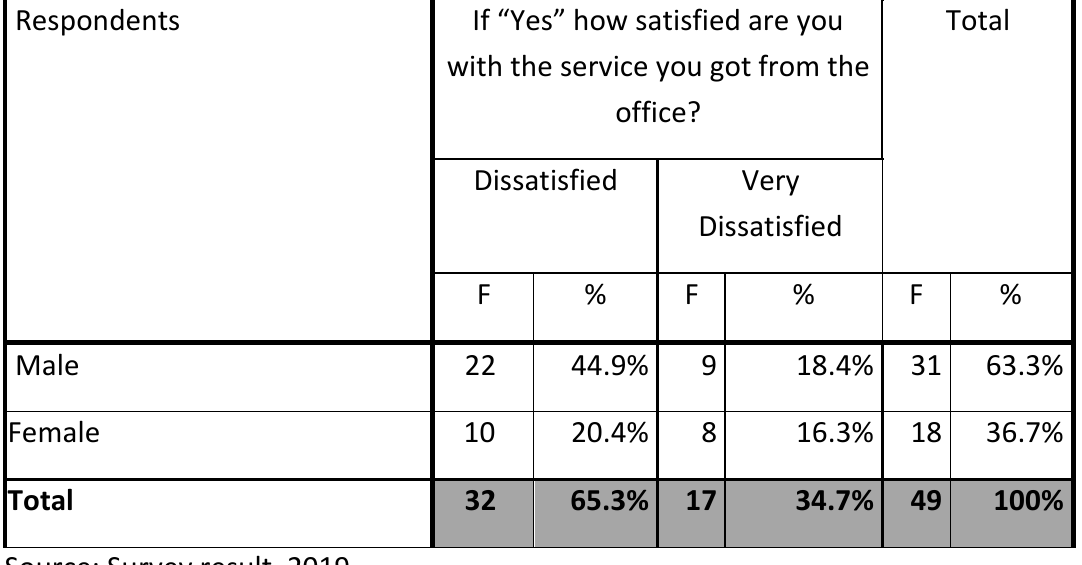
Table 7: Public Satisfaction regarding compliant handling office’s service provision